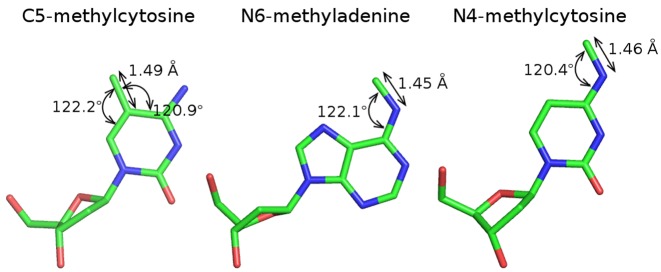
Selected geometric parameters of the methylated bases used for the deduction of the methyl group positions. Only the base atoms were used for superposition with the non-methylated bases present in the restriction endonuclease-DNA crystal structures, sugars are shown for clarity.